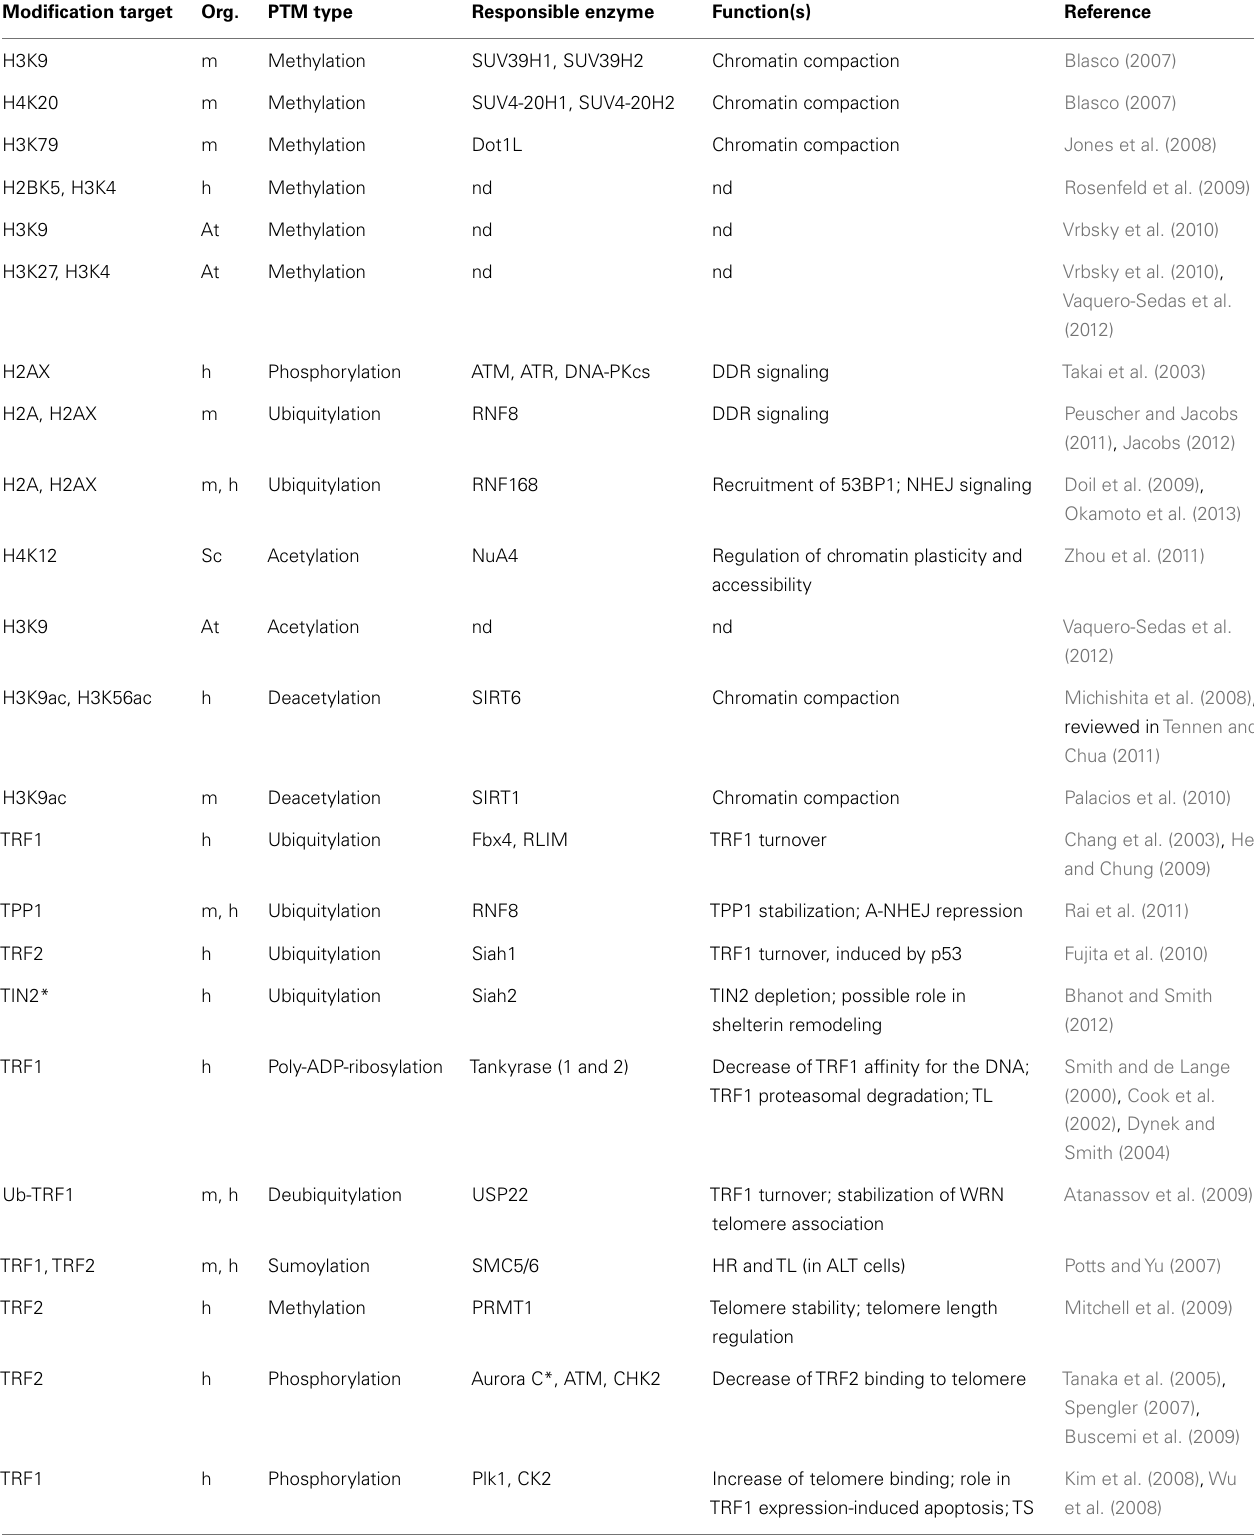
Table 2 | Post-translational modifications (PTM) at telomeres. Modification